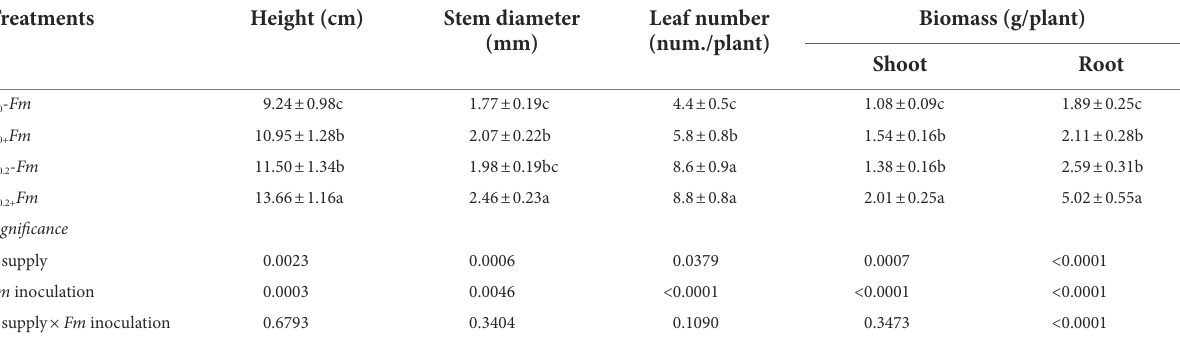
TABLE 2 Effects of Funneliformis mosseae and P supply on plant growth performance of Polygonum cuspidatum Sieb. et